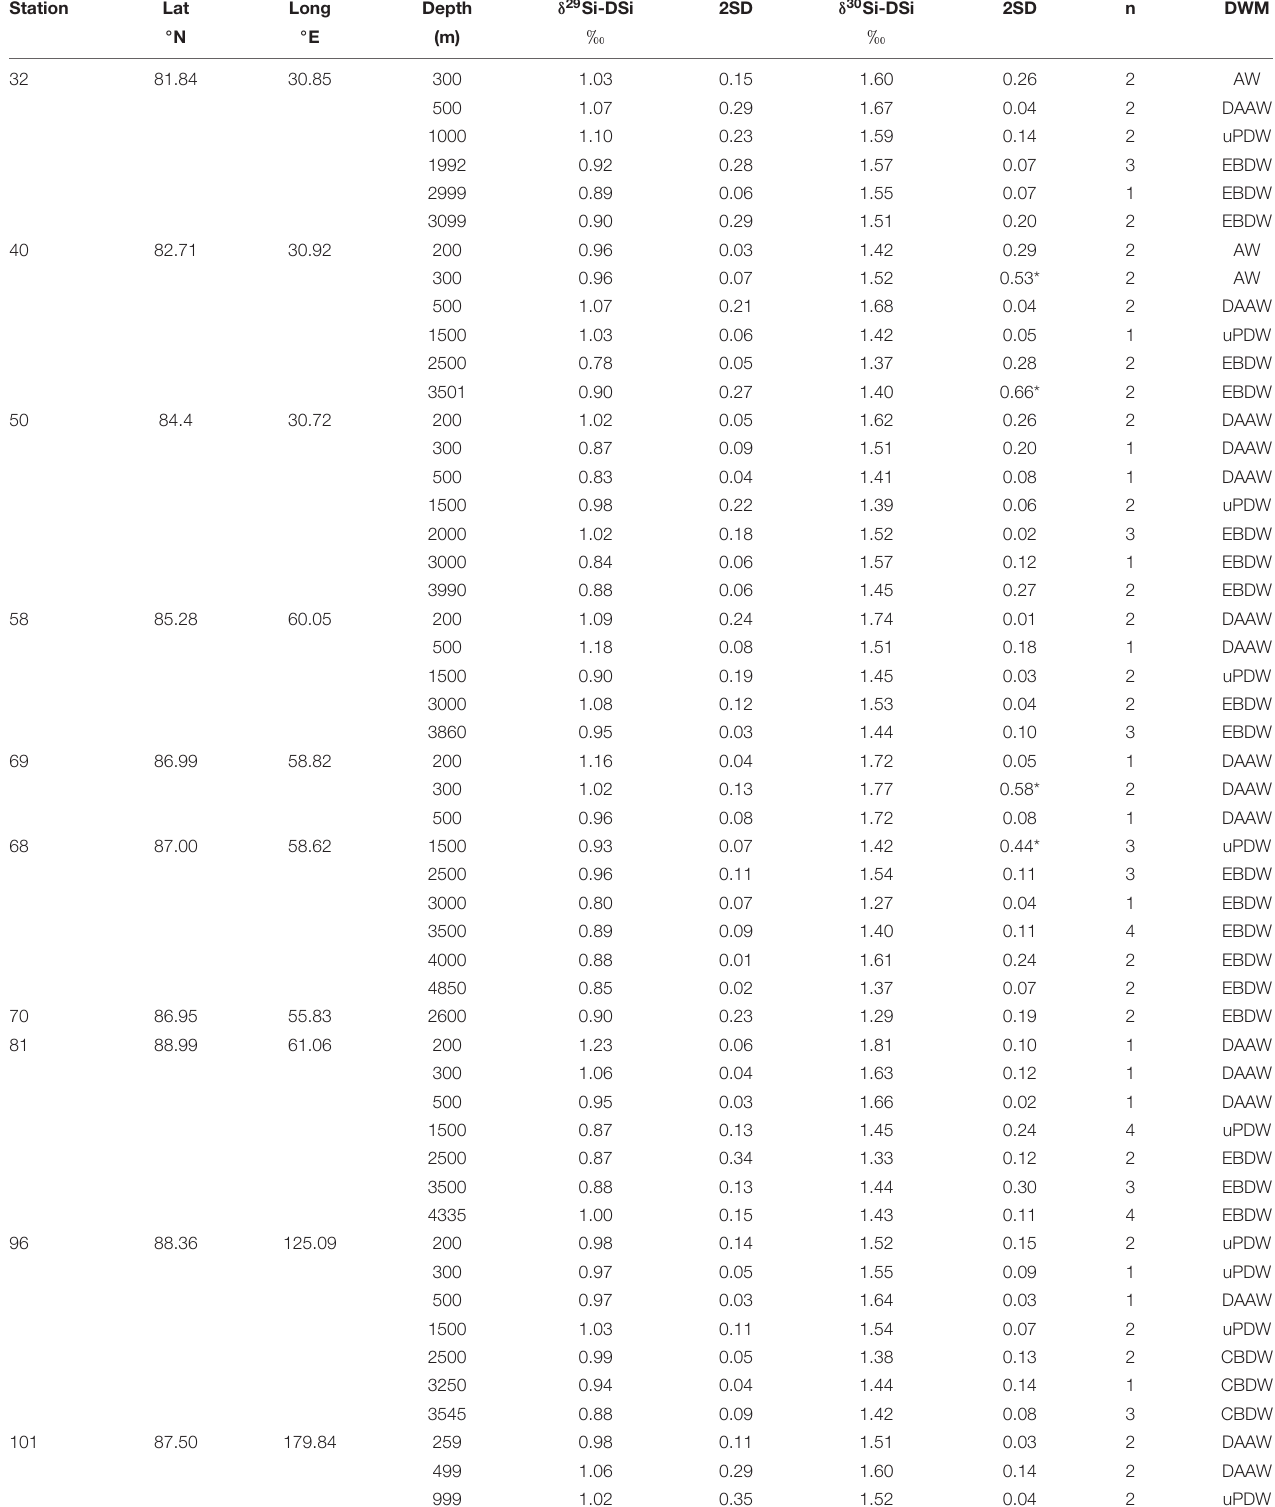
TABLE 2 | Sample locations from the RV Polarstern cruise PS94, collected between August and October 2015 along with δ 29 Si-DSi δ 30 Si-DSi. Station Lat